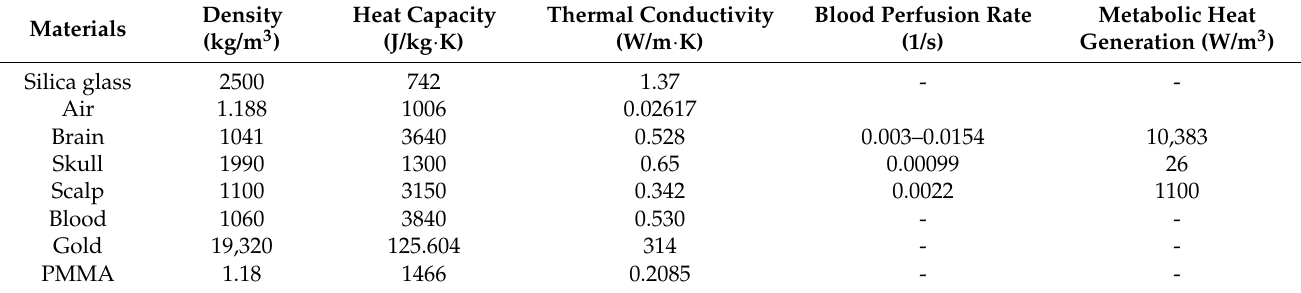
Table 1. Material properties applied in the computational simulation